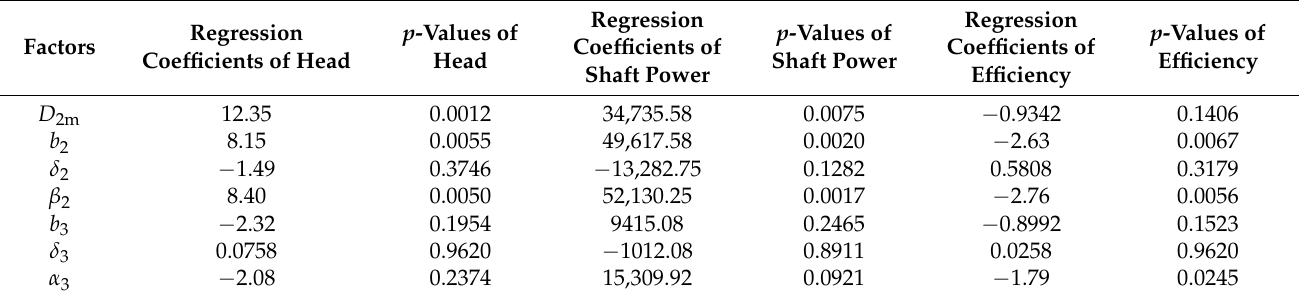
Table 7. Regression coefficients and significance test results.